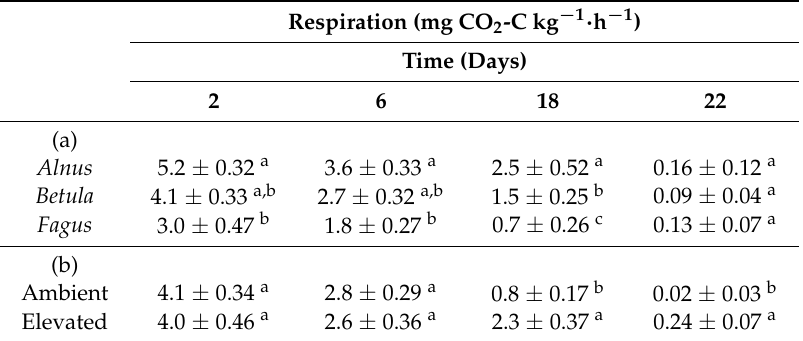
Table 3. Effect of ( a ) litter species and ( b ) CO 2 regime on respiration in earthworm casts at four incubation times—mesocosm experiment.